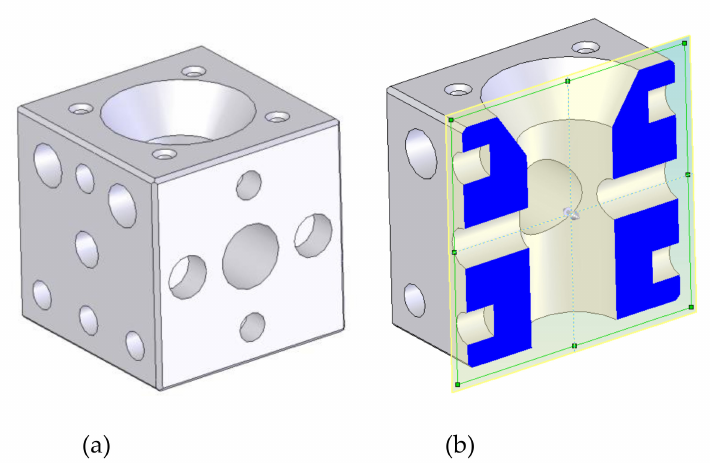
Figure 6. AR unit design after applying the MEEM model. It presents different types of nest cavities. ( a ) 3D; ( b )